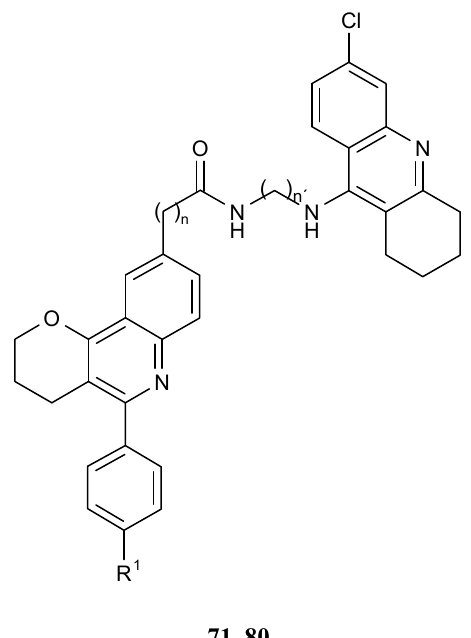
Figure 16. Heterotacrine-quinoline hybrids 71–80 .